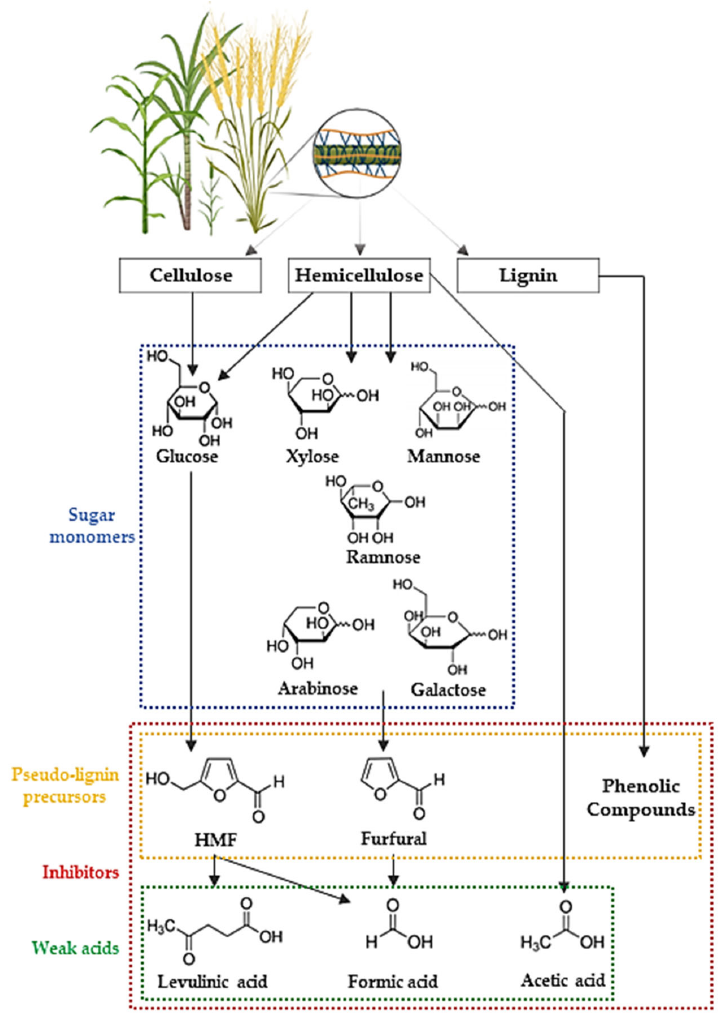
Figure 2. Quick scheme of the main inhibitory compounds formed in the hydrolysis of lignocellulosic biomass during acid and/or hydrothermal pretreatment.